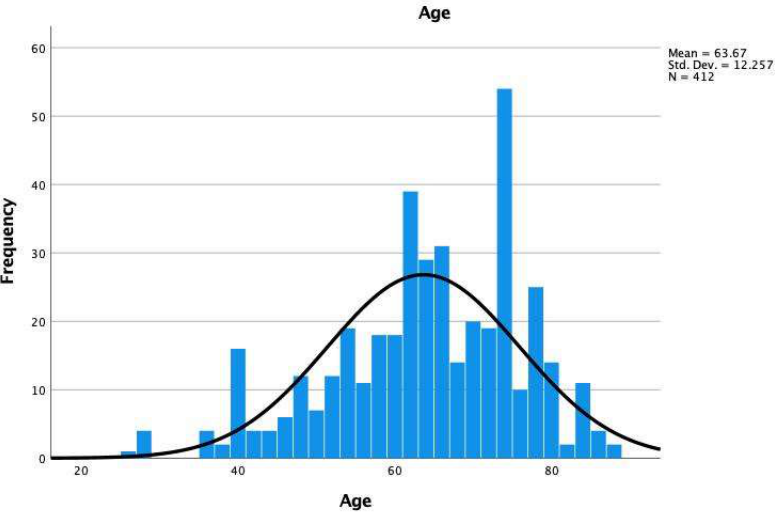
Figure 2. Histogram of the age distribution of the 412 study patients with a mean age of 63.67 ranging from 26 to 88 years with a standard deviation of 12.257 years.